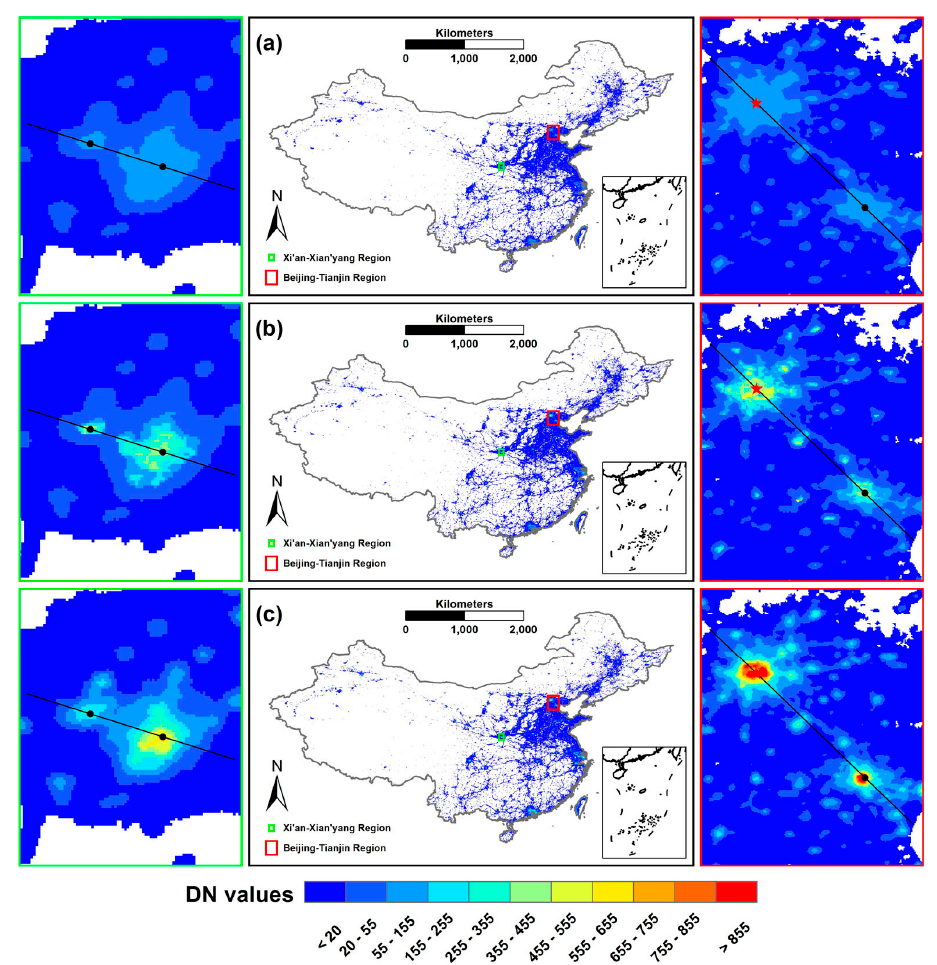
Figure 9. Nighttime lights images before and after saturation correction. ( a – c ) Charts correspond to the 2006 SNL image, corrected image, and RCNL image, respectively.